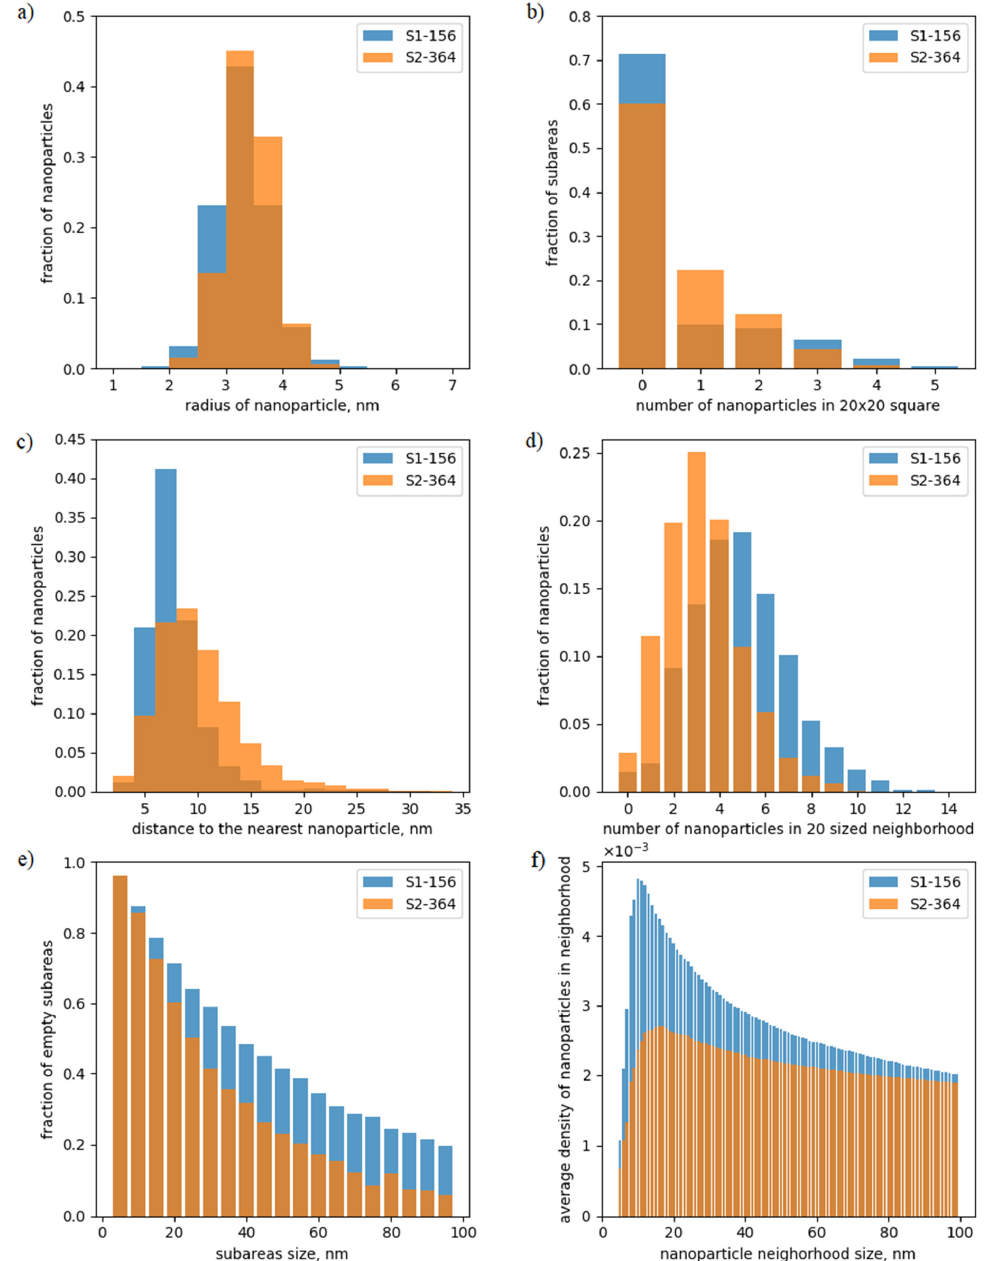
Figure 3. Visual presentation of calculated statistical data for two images from Figure 2 (see the text below for the explanations).